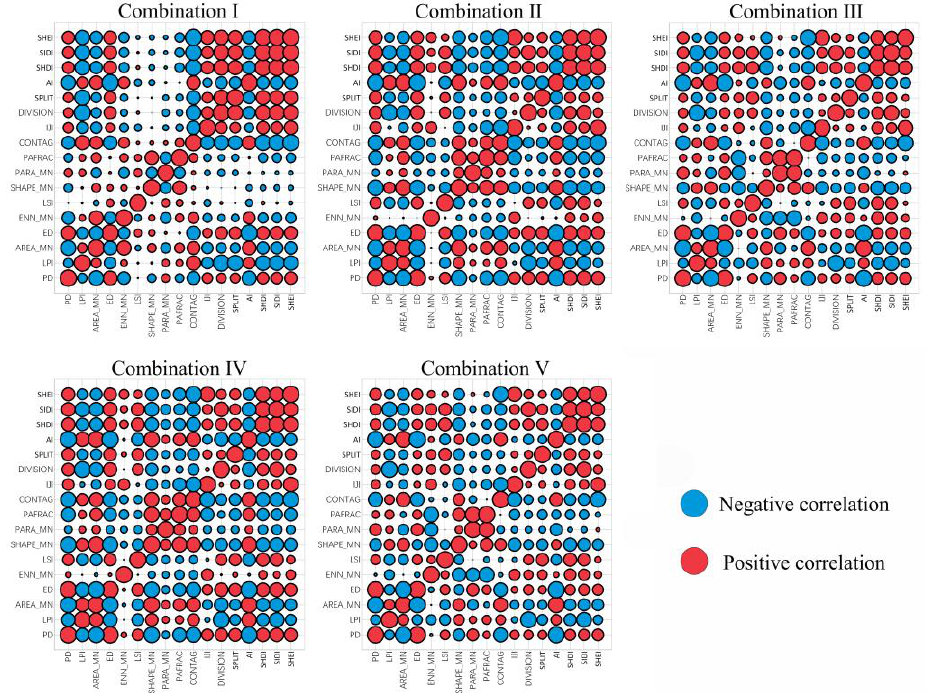
Figure 5. Correlation matrix of landscape metrics under five different combinations.